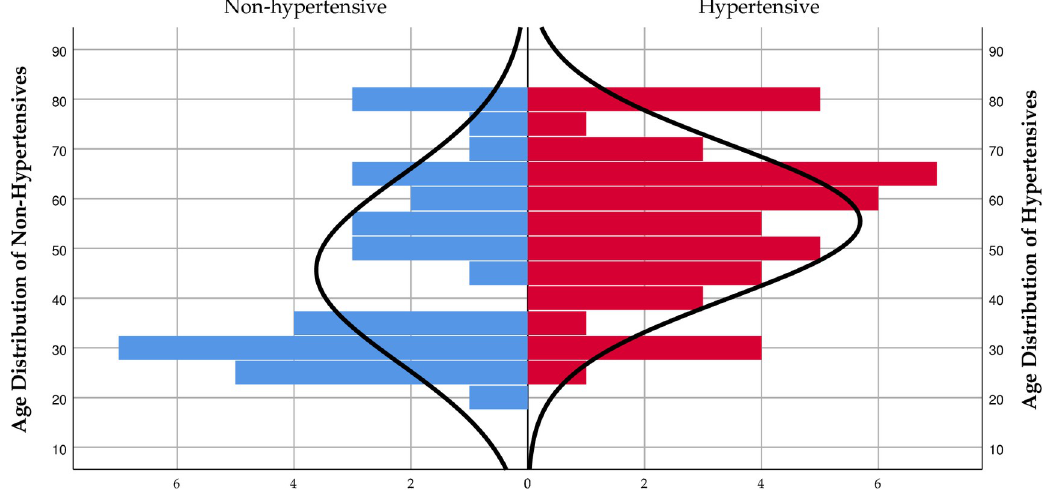
Fig 3. Age distribution population pyramid over hypertension among male residents of Nyive.